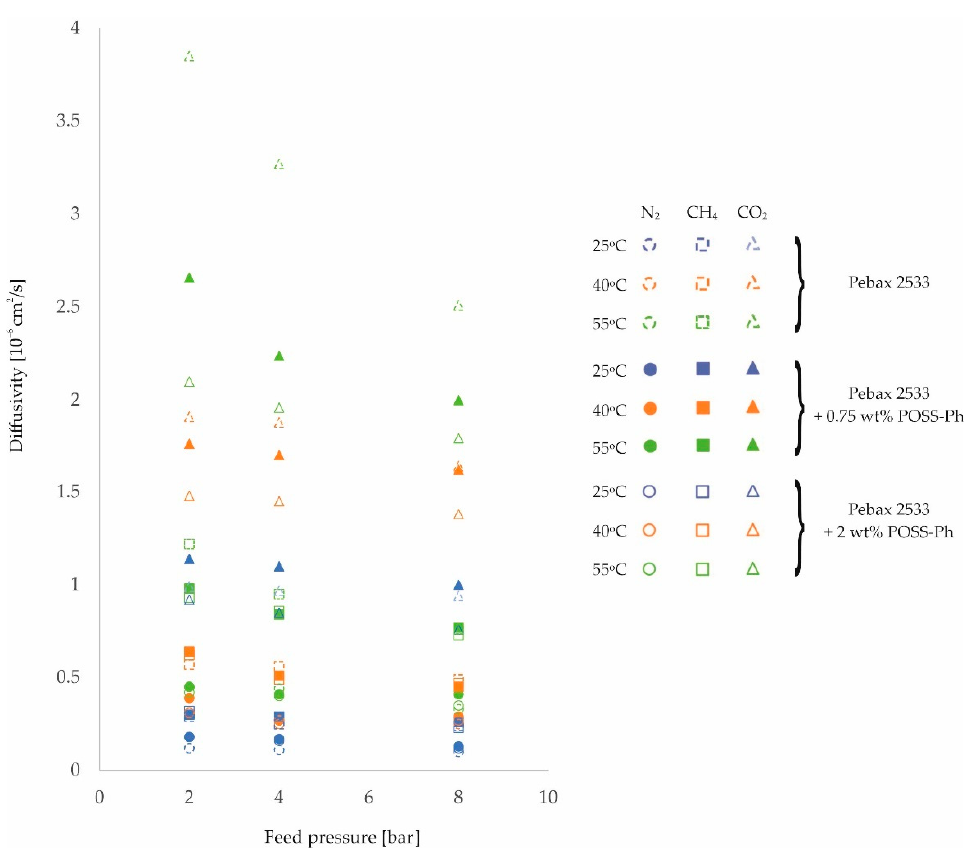
Figure 6. Change in diffusion coefficient values of homogeneous membrane and heterogeneous membranes containing POSS ‐ Ph for different feed pressure and temperature values.